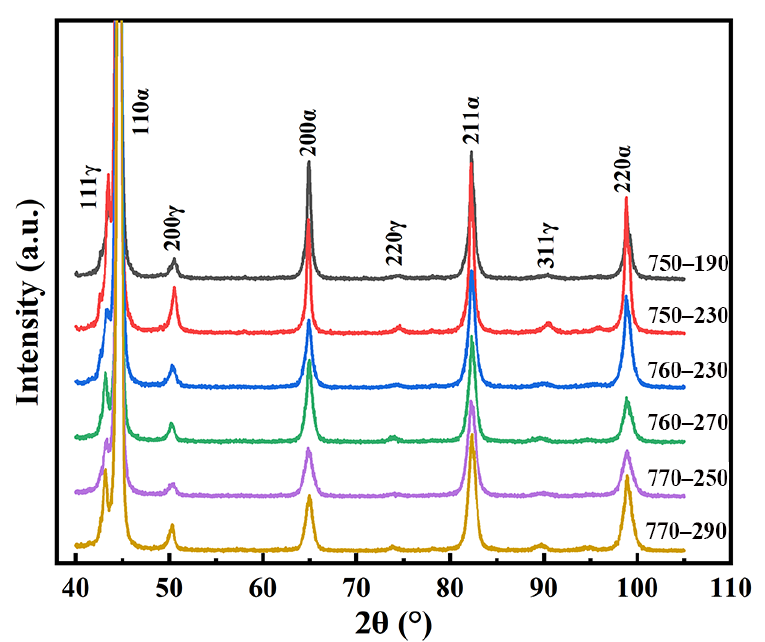
Figure 6. XRD patterns of the test steel following different heat treatment processes.